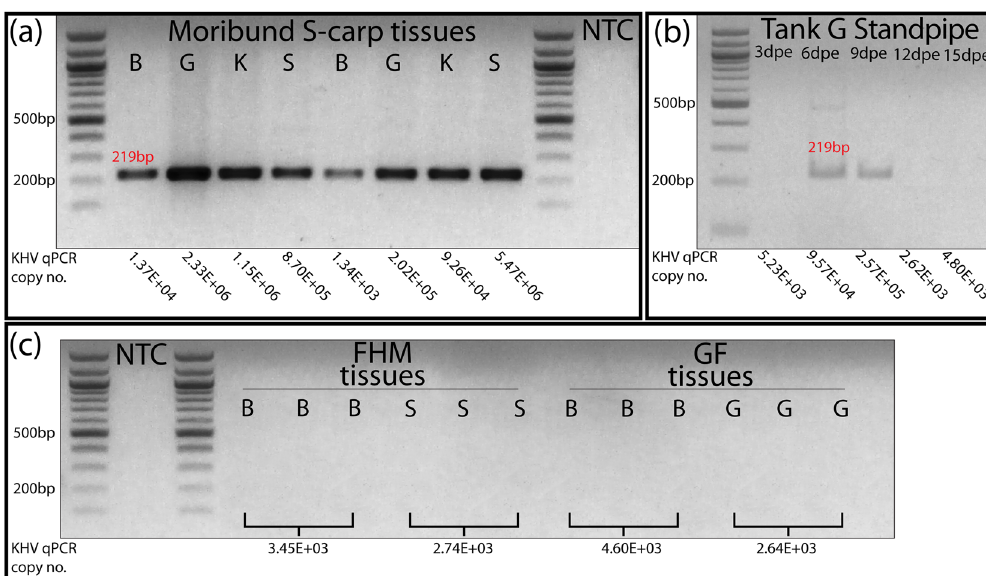
Figure 7. ( a – c ) Show UV fluorescence of RT-PCR products on 2% agarose gels stained with ethidium bromide. Bands for 500 and 200 bp on the DNA ladders are noted. The position of 219 bp is denoted in red. S-carp cohabitated sentinel carp, FHM fathead minnow, goldfish, B brain, G gill, K kidney, S skin, NTC no template control. In ( b ) “standpipe” indicates swabs of the tank outflow standpipe filer. CyHV-3 specific qPCR copy numbers/mL of tissue supernatant from corresponding tissues are displayed below each lane. Samples in ( a ) are representative tissues from S-carp from tank A (first 4 samples) and from tank C (last 4 samples). Samples in ( c ) are triplicate tests of FHM and goldfish tissues which had positive qPCR